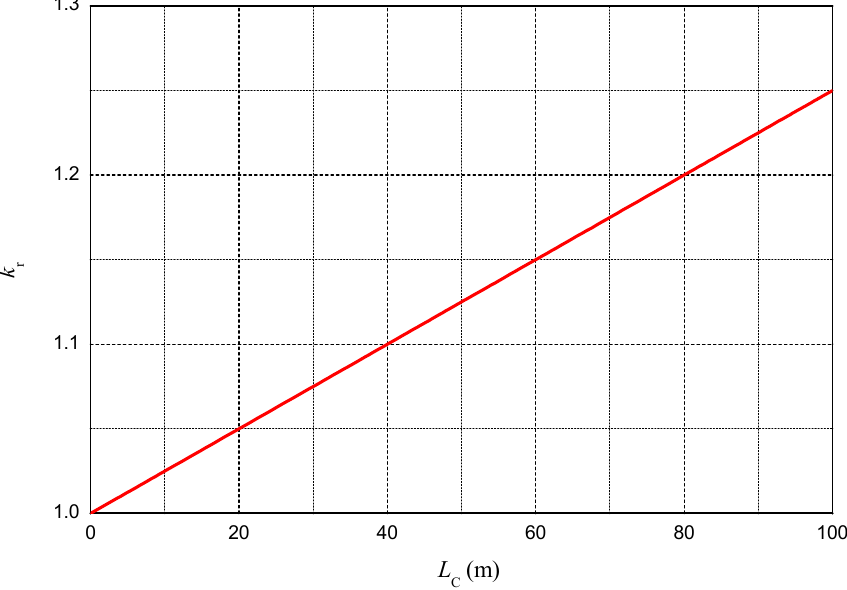
Figure 6. Reflection coefficient k r of voltage propagating along the connected LV circuit as function of its length L C .